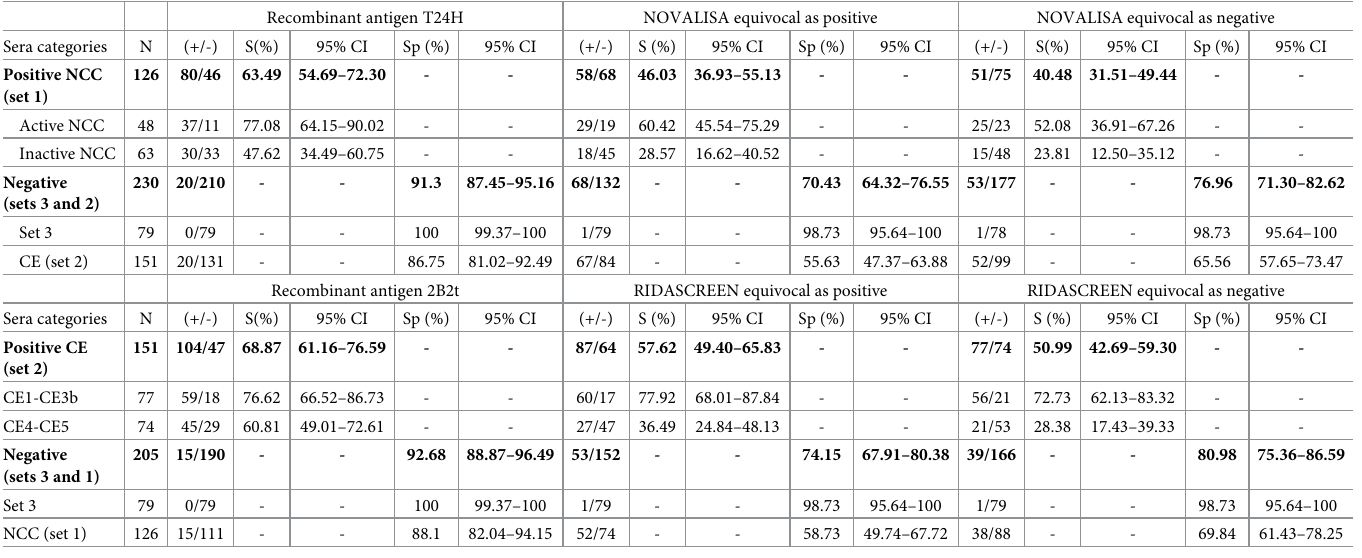
Table 5. Diagnostic accuracy of rT24H- and r2B2t- MBA, and Novalisa, Ridascreen ELISA assay when ELISA equivocal results were considered as positive or negative. Recombinant antigen